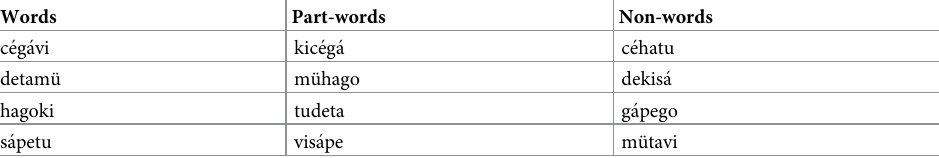
Table 1. Words, part-words and non-words used in the 2AFC task.